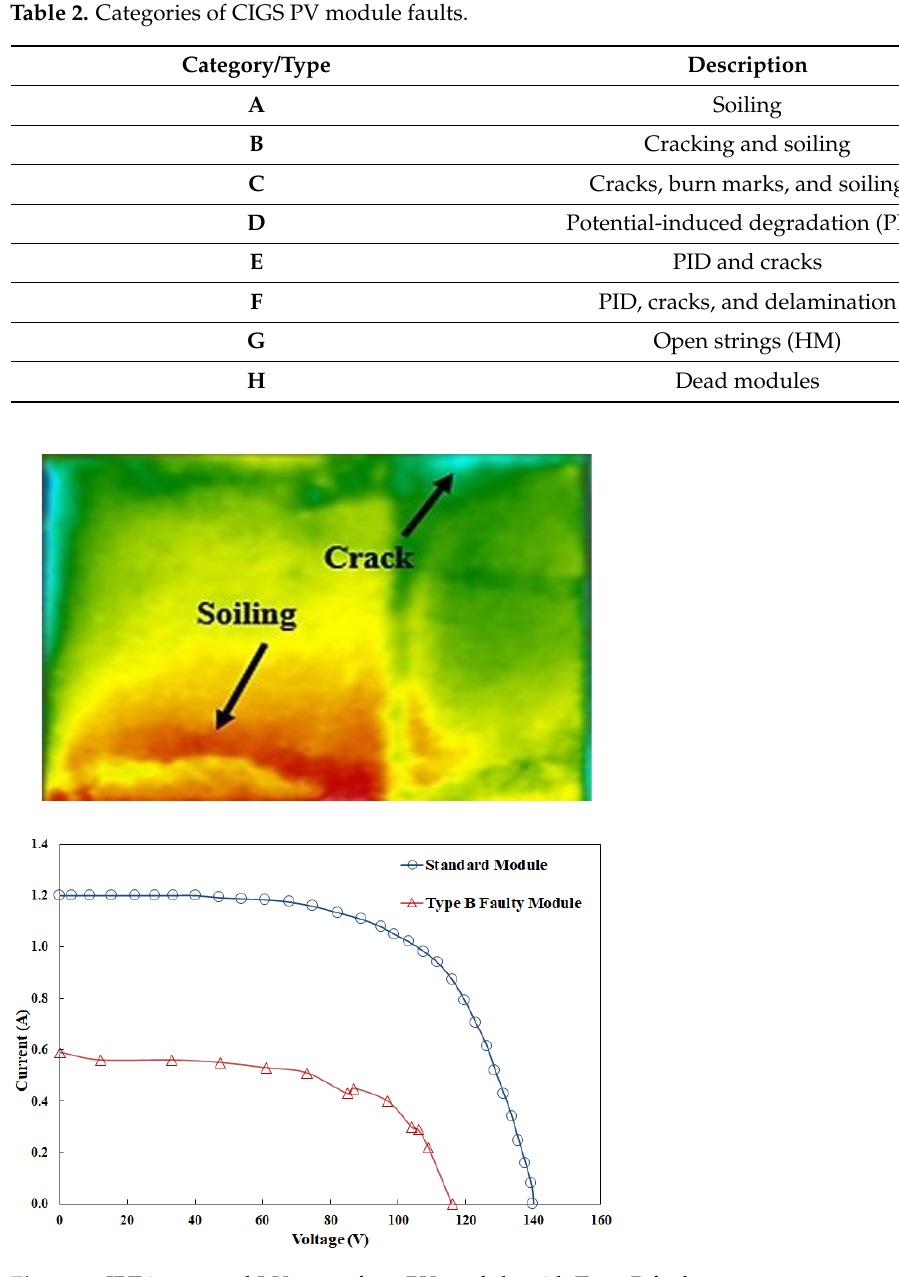
Figure 2. IRT image and I-V curve for a PV module with Type-B fault.